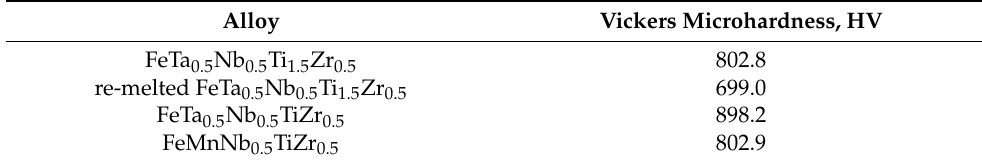
Figure 20. X-ray diffraction pattern for the FeMnNb 0.5 TiZr 0.5 alloy. Table 8. Vickers microhardness for the obtained